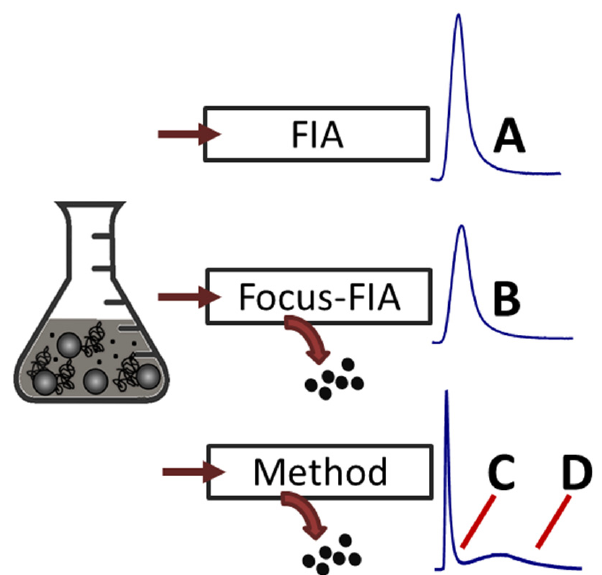
Figure 5. Schematization of the FFF fraction collection approach used to obtain comparable fractions